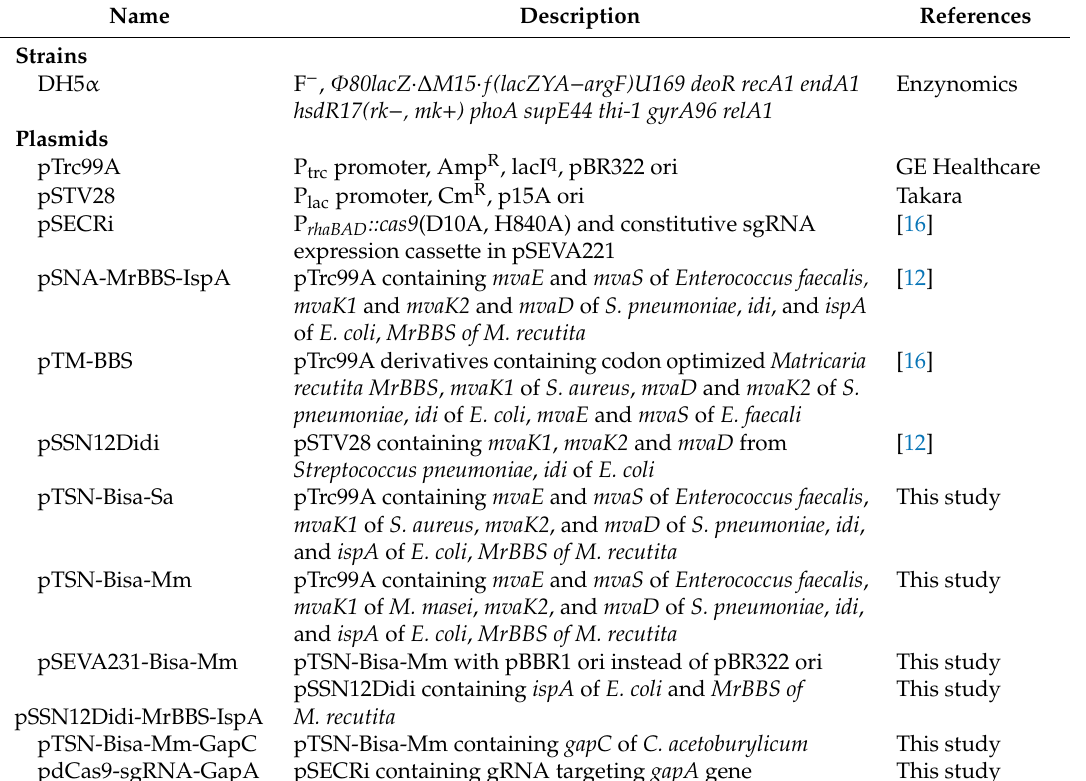
Table 2. Strains and plasmids used in this